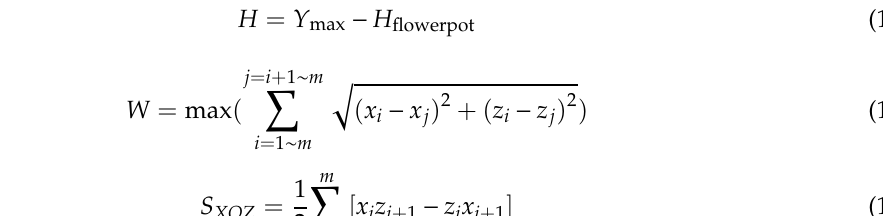
Figure 7. Analysis of point cloud reconstruction of the GTPs: ( a ) Distribution of the H RS sets of the